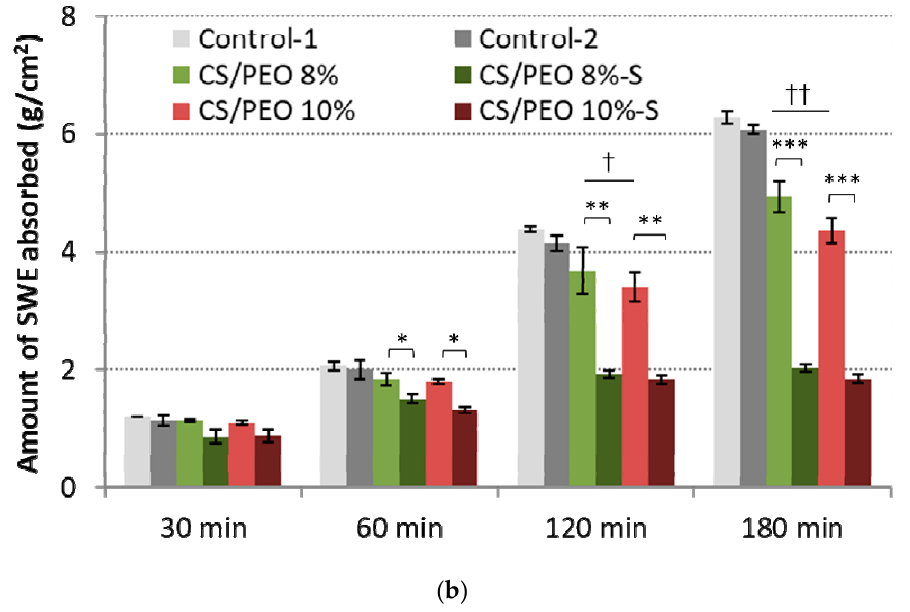
Figure 5. Total simulated wound exudate fluid absorption response of CS/PEO nanofibers and commercial wound dressings (Control-1; Control-2) at: ( a ) low (0.6 mL/h), and ( b ) high fluid flow rate (2.0 mL/h) (mean ± S.D.; n = 3); * represents significant differences with p ≤ 0.05, ** represents significant differences with p ≤ 0.01, while *** represents significant differences with p ≤ 0.001 between uncoated and S-coated nanofibers; † and †† symbolize significant differences with p ≤ 0.05 and p ≤ 0.01 between uncoated nanofibers and Controls, respectively.